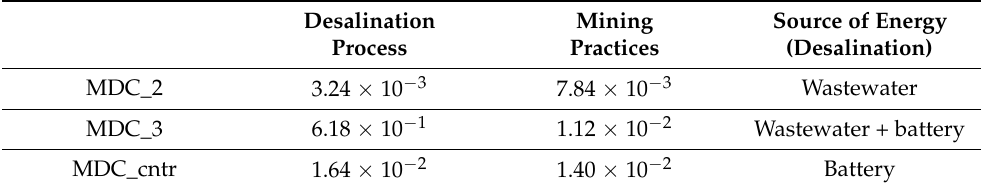
Table 5. Energy provided to the MDCs’ systems by either battery and/or wastewater (en- ergy unit/treated brine volume) to separate metals from brine and cumulative energy demand (Nuss et al., 2014). All values are expressed as MJ/m 3